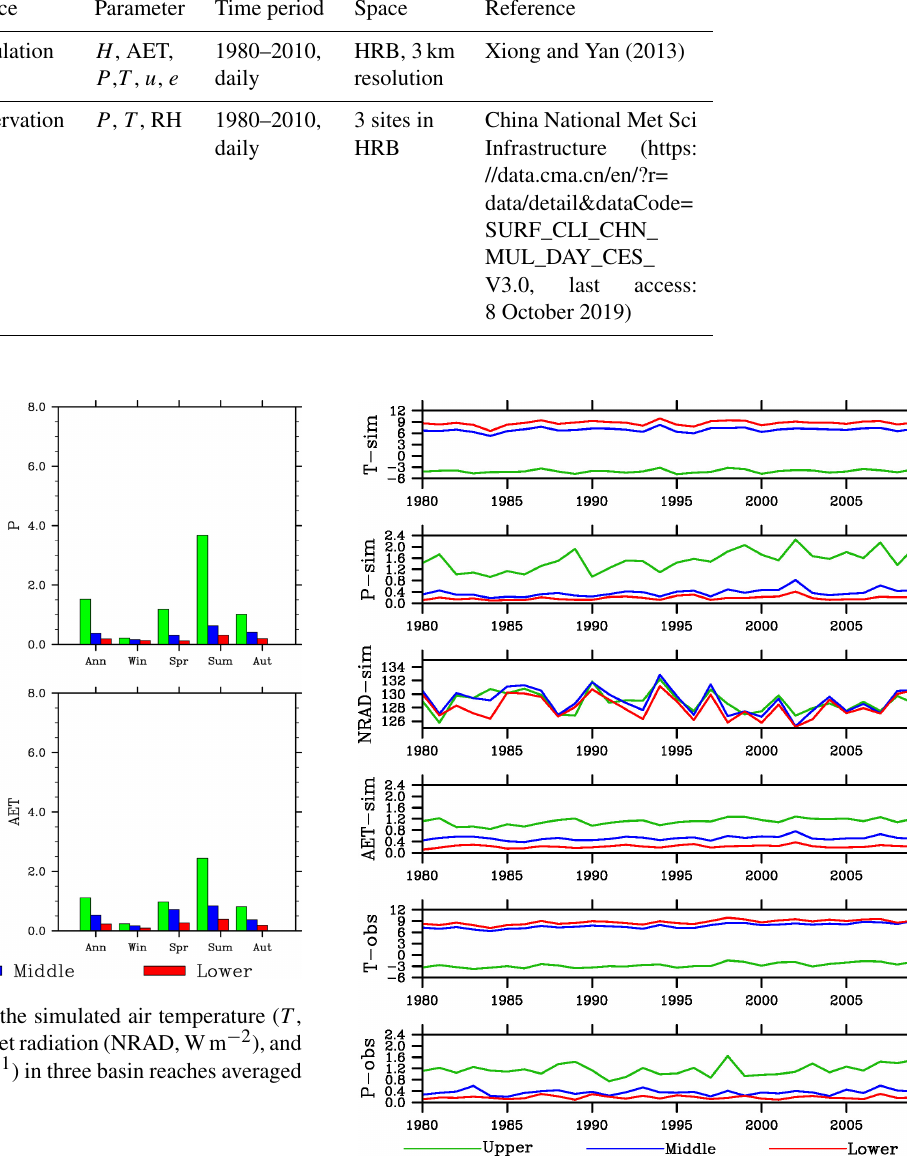
Figure 4. Interannual variations of the simulated air temperature ( T , ◦ C), precipitation ( P , mmd − 1 ), net radiation (NRAD, Wm − 2 ) and actual evapotranspiration (mmd − 1 ), and observed air temperature ( T , ◦ C) and precipitation ( P , mmd − 1 ) in three basin reaches